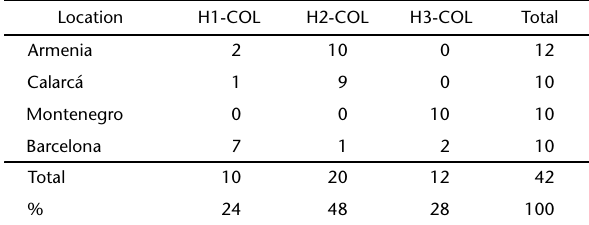
Table III. Number of individuals observed for each haplotype in samples of four populations of Aedes aegypti from Colombia.